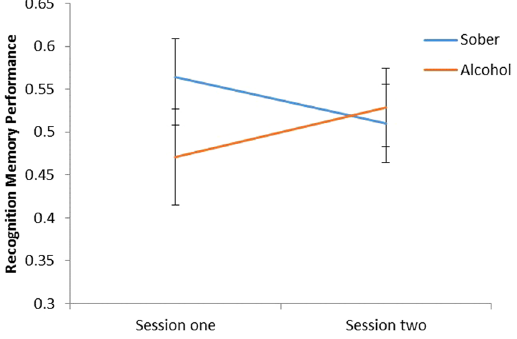
Figure 5. The interaction between session and condition on recognition memory performance during the acute memory task. A significant decline in performance was found between sessions in the sober group only ( p = 0.021). There were no significant group differences.